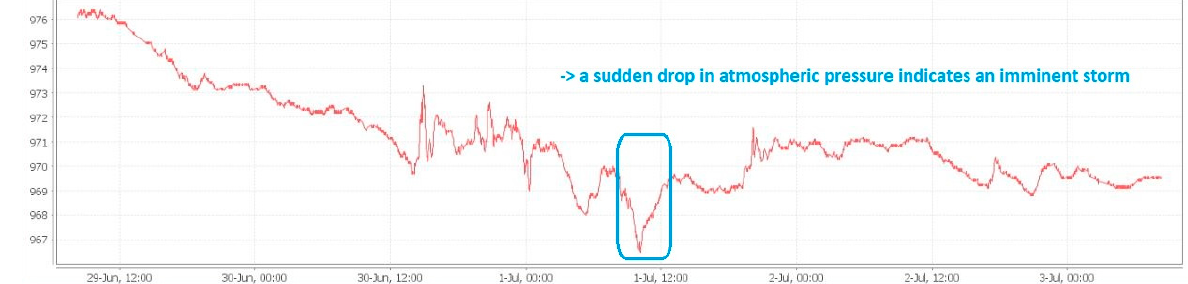
Figure 12. Local microclimate monitoring in LV/MV switchgear cells, indication of imminent storm: sudden drop in atmospheric pressure in 1 July 2021 before 12:00 PM.